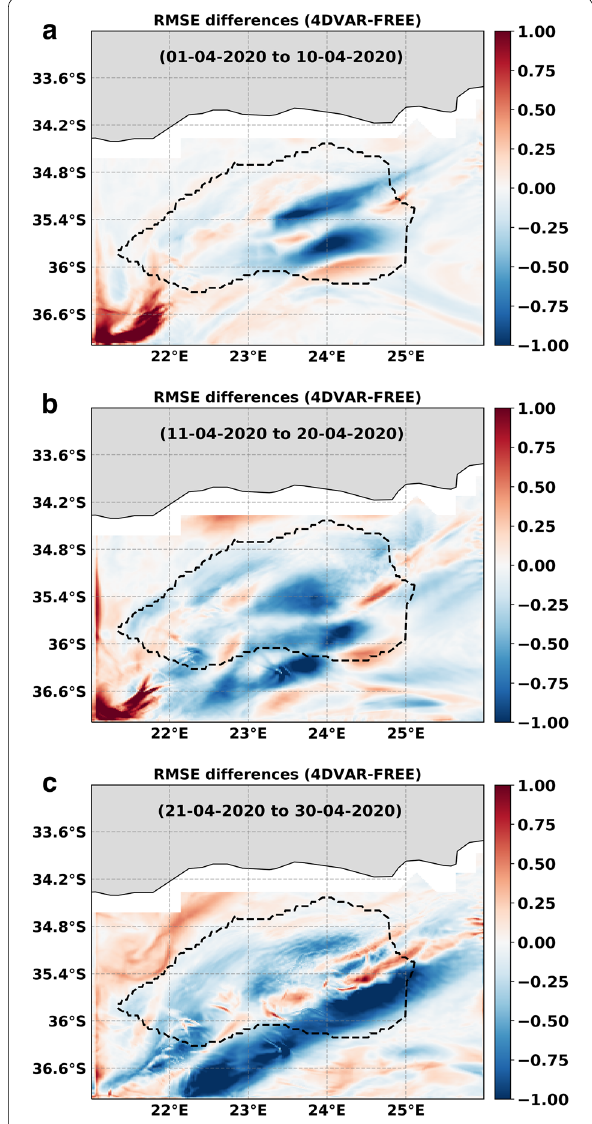
Fig. 5 Maps of differences of FREE and 4DVAR geostrophic velocities RMSE (against altimeter derived velocities) during April 2020. a corresponds to the 1 st to 10 th of April, b corresponds to the 11 th to the 20 th of April and c corresponds to the 21 th to the 30 th of April. Blue color means RMSE reduction in 4DVAR solution. Dotted contour shows where HF radar data are